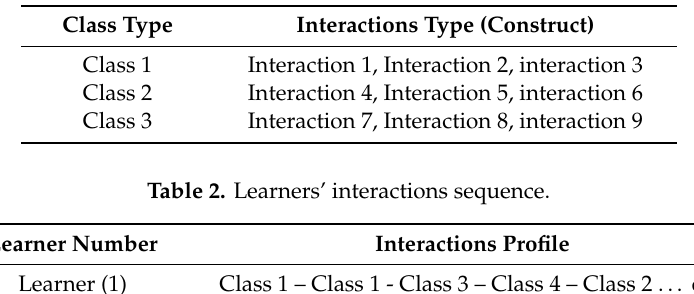
Table 1. Classes of interactions.